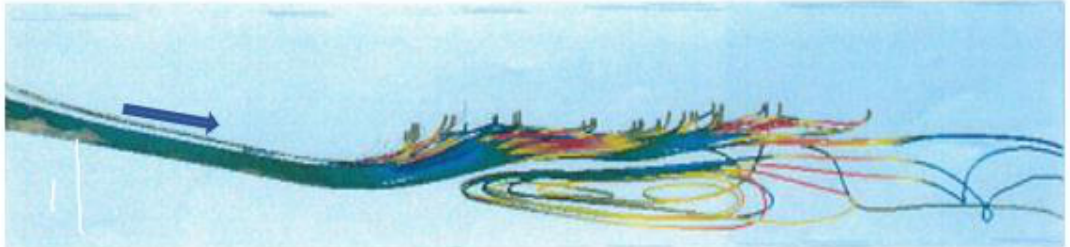
Figure 16. X plane CFD computed streamline patterns within the Figure 15 structure, indicating complex vortex patterns and high turbulence levels. Arrow denotes flow direction.